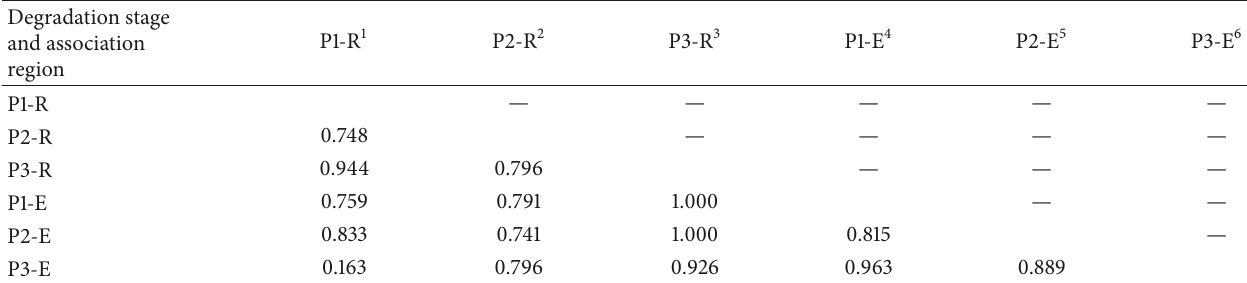
Table 5: Values of 𝑅 of the analysis of similarity of the culture-independent total diazotrophic bacterial community determined through Denaturing Gradient Gel Electrophoresis (DGGE) of the nif H gene in different regions of the plant/bacteria association in B. decumbens Stapf. pasture in different stages of